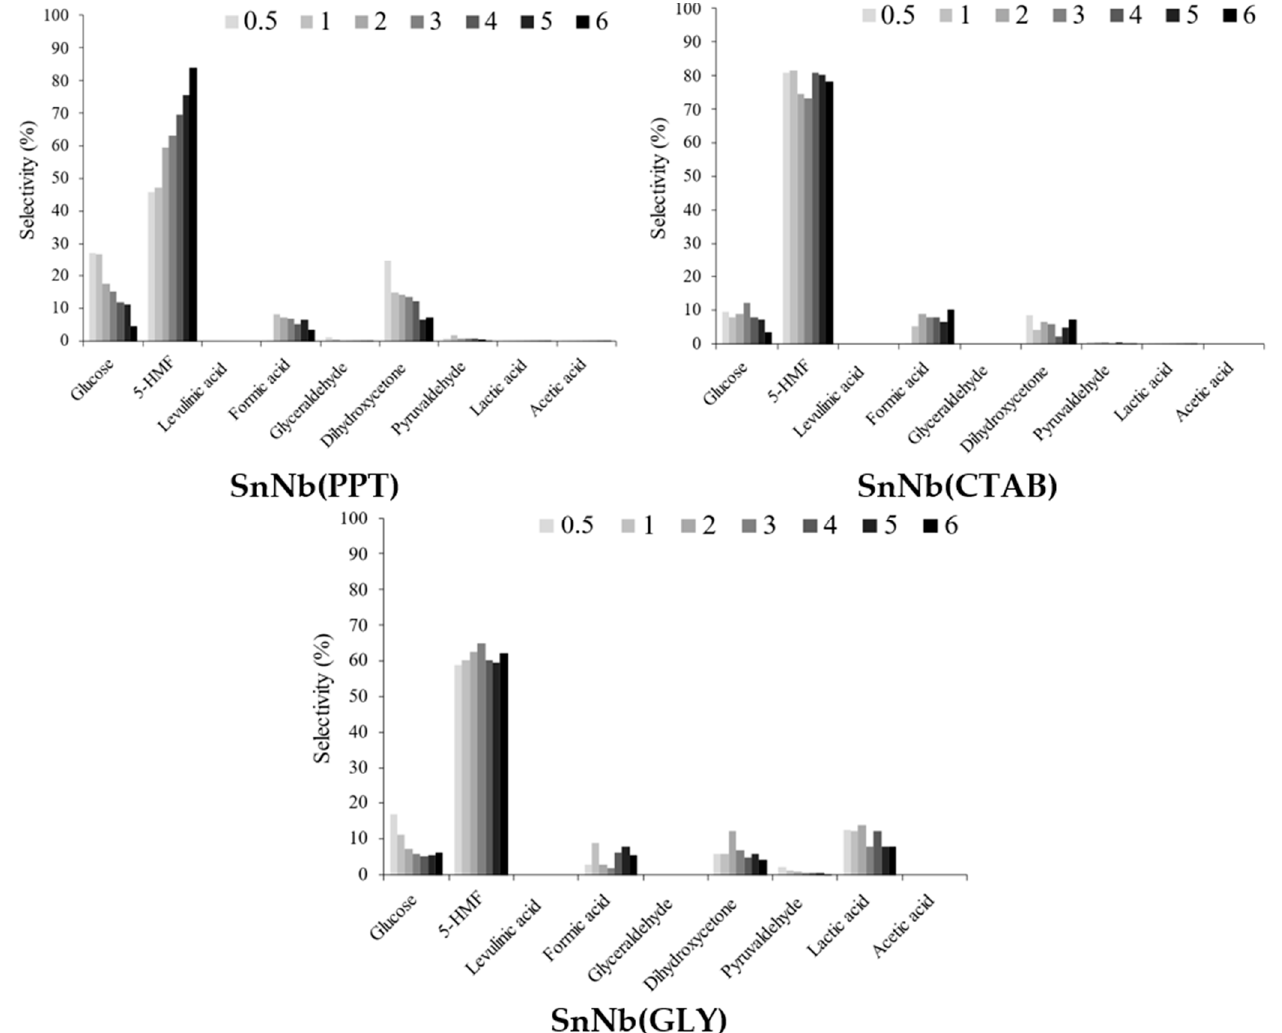
Figure 9. Selectivity for soluble products identified in the fructose conversion at 150 °C, using 1.5 × 10 − 3 g of SnNb(PPT), SnNb(CTAB) and SnNb(GLY). 1.5 × 10 − 3 g of SnNb(PPT), SnNb(CTAB) and